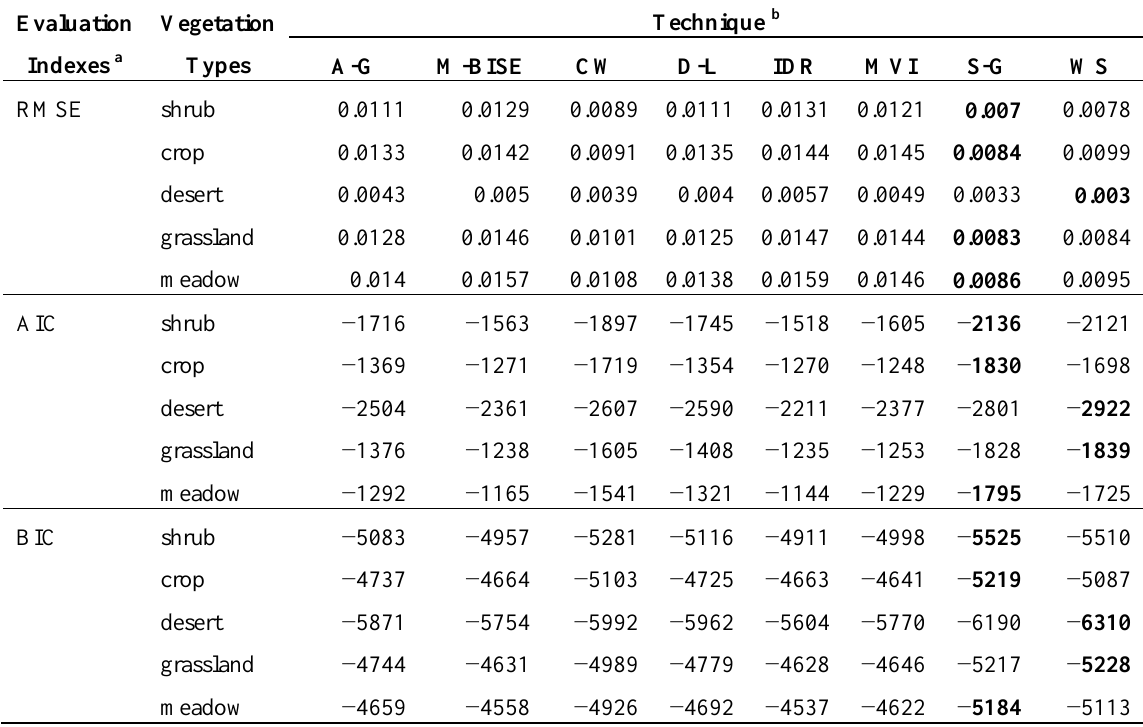
Table 5. RMSE, AIC, and BIC values for the eight techniques for SPOT VGT NDVI time-series data from April 1998 to April 2013 (best-fitting technique shown in